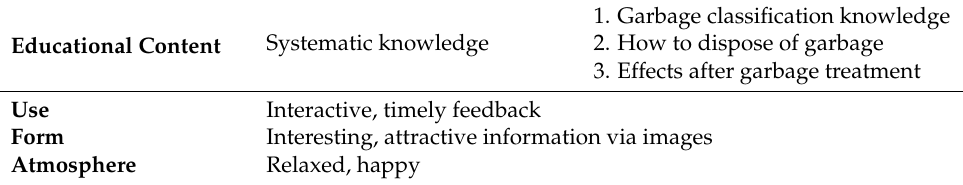
Table 2. Summary of design strategies.